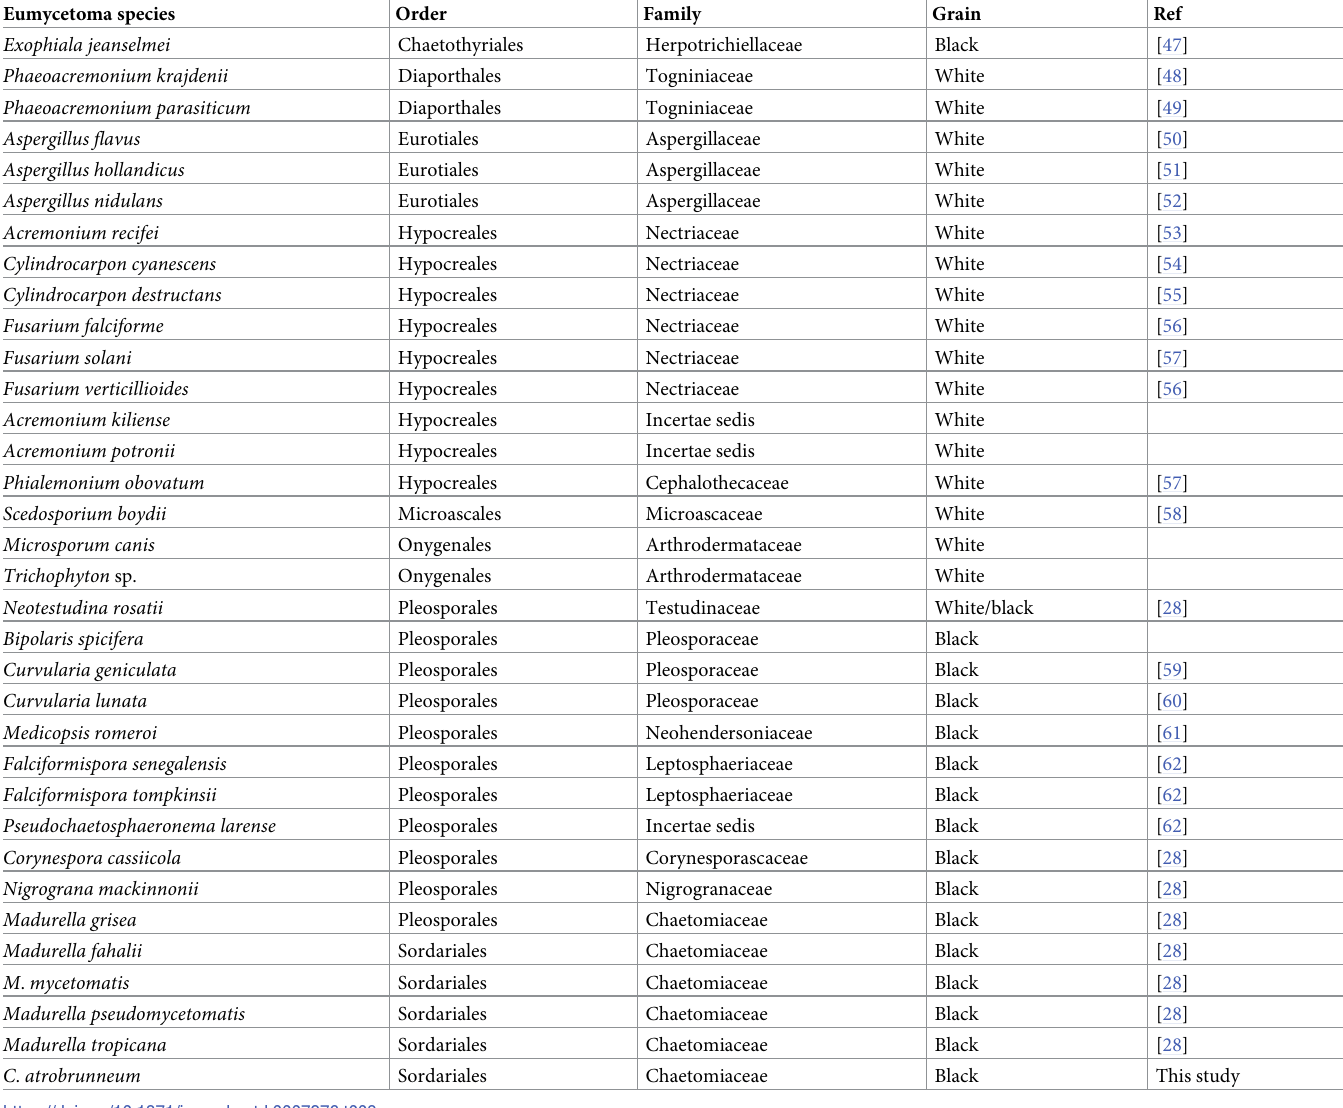
Table 3. Eumycetoma-causing